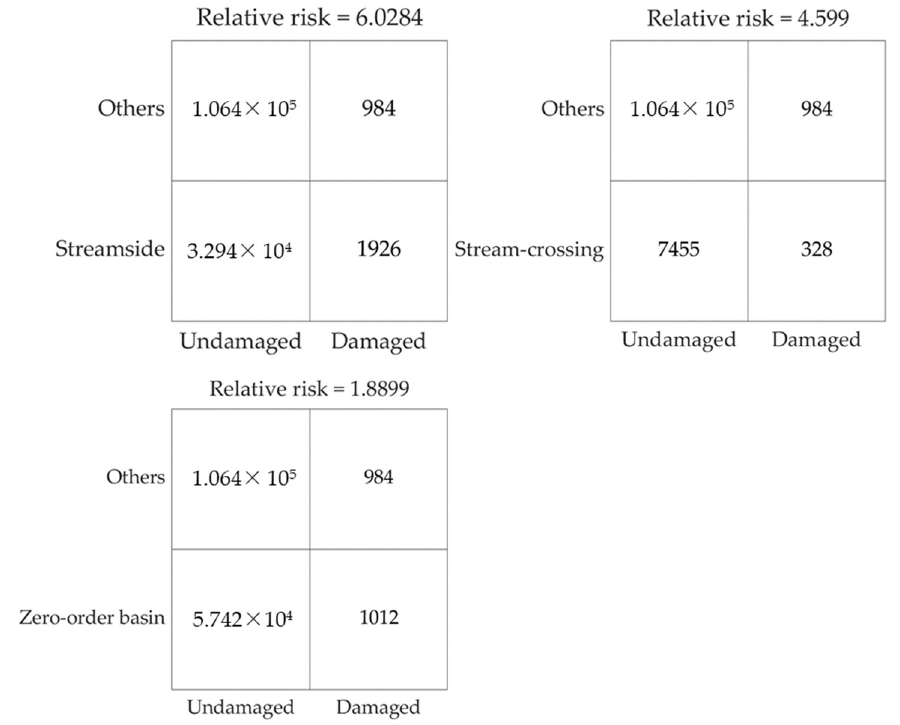
Figure 9. Cross tabulation table of forest road segment topography form and damage status. Rows correspond to the topographic form of the forest road segment, and columns correspond to the damage status.